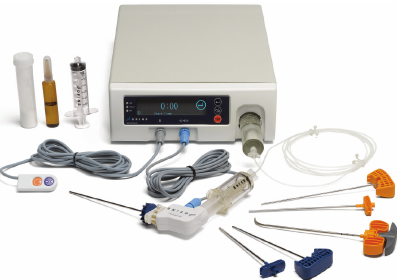
Figure 1: StabiliT Vertebral Augmentation System (DFINE, Inc., San Jose, CA,